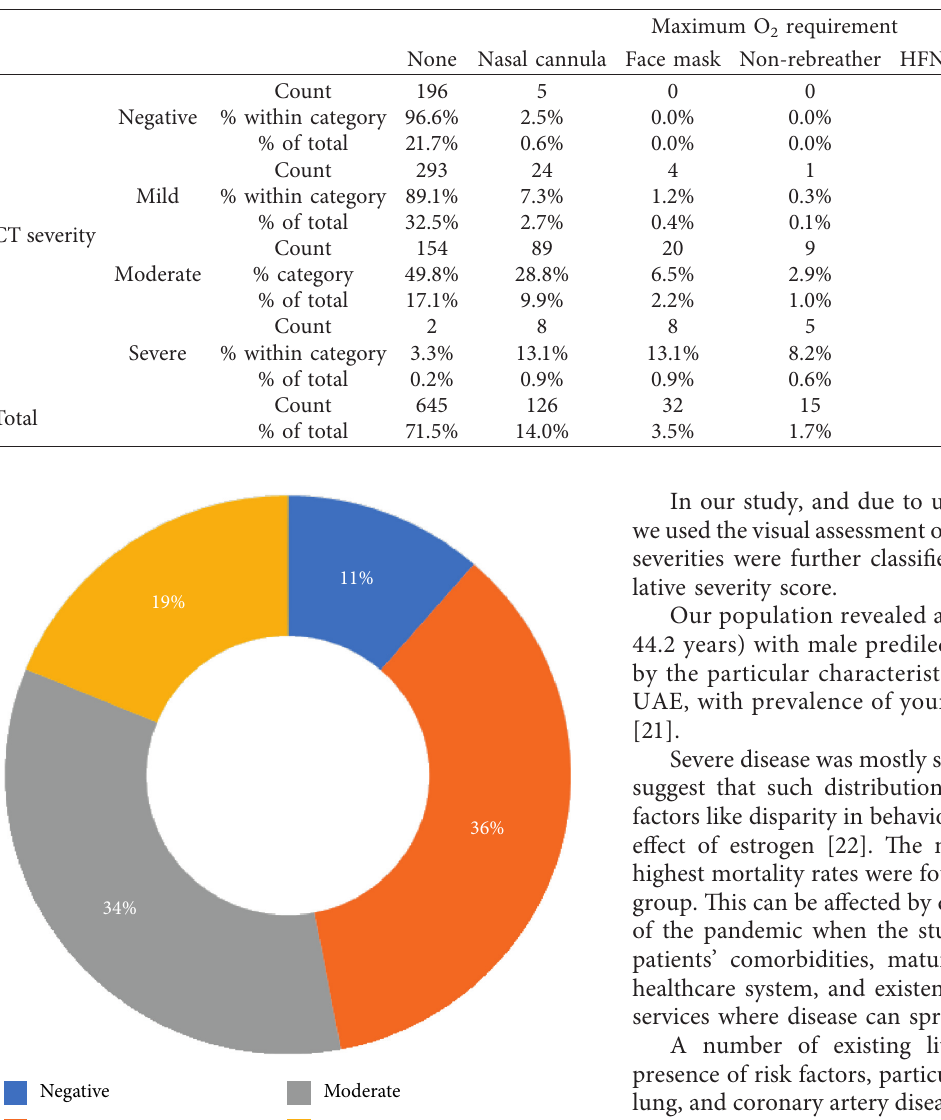
Table 3: Maximum oxygen requirement in each CT severity category.